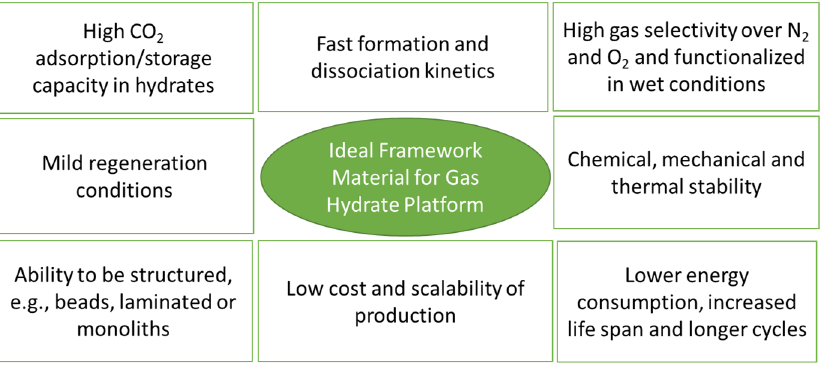
Figure 15. Key factors responsible for high gas uptake in nano ‐ confined water in